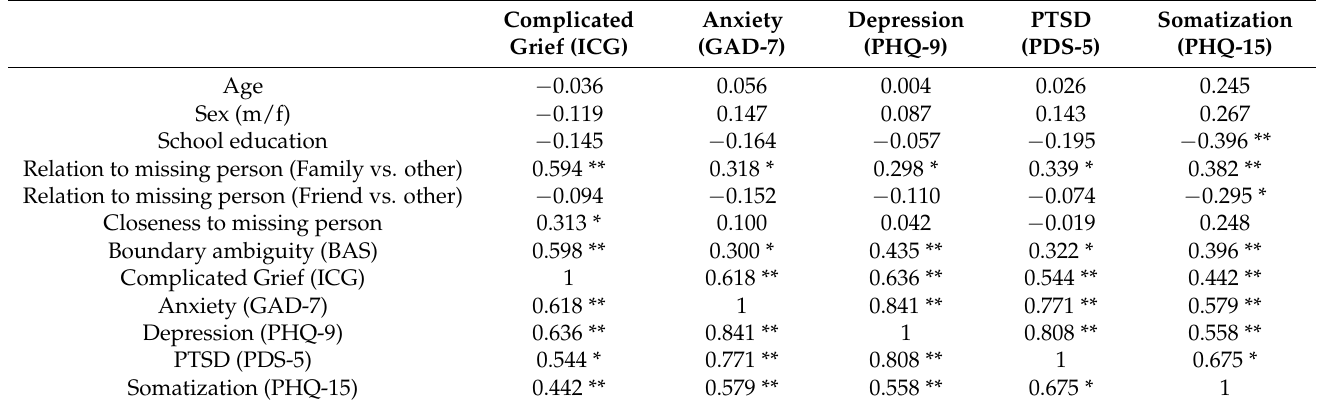
Table 1. Pearson correlations of predictors and mental health